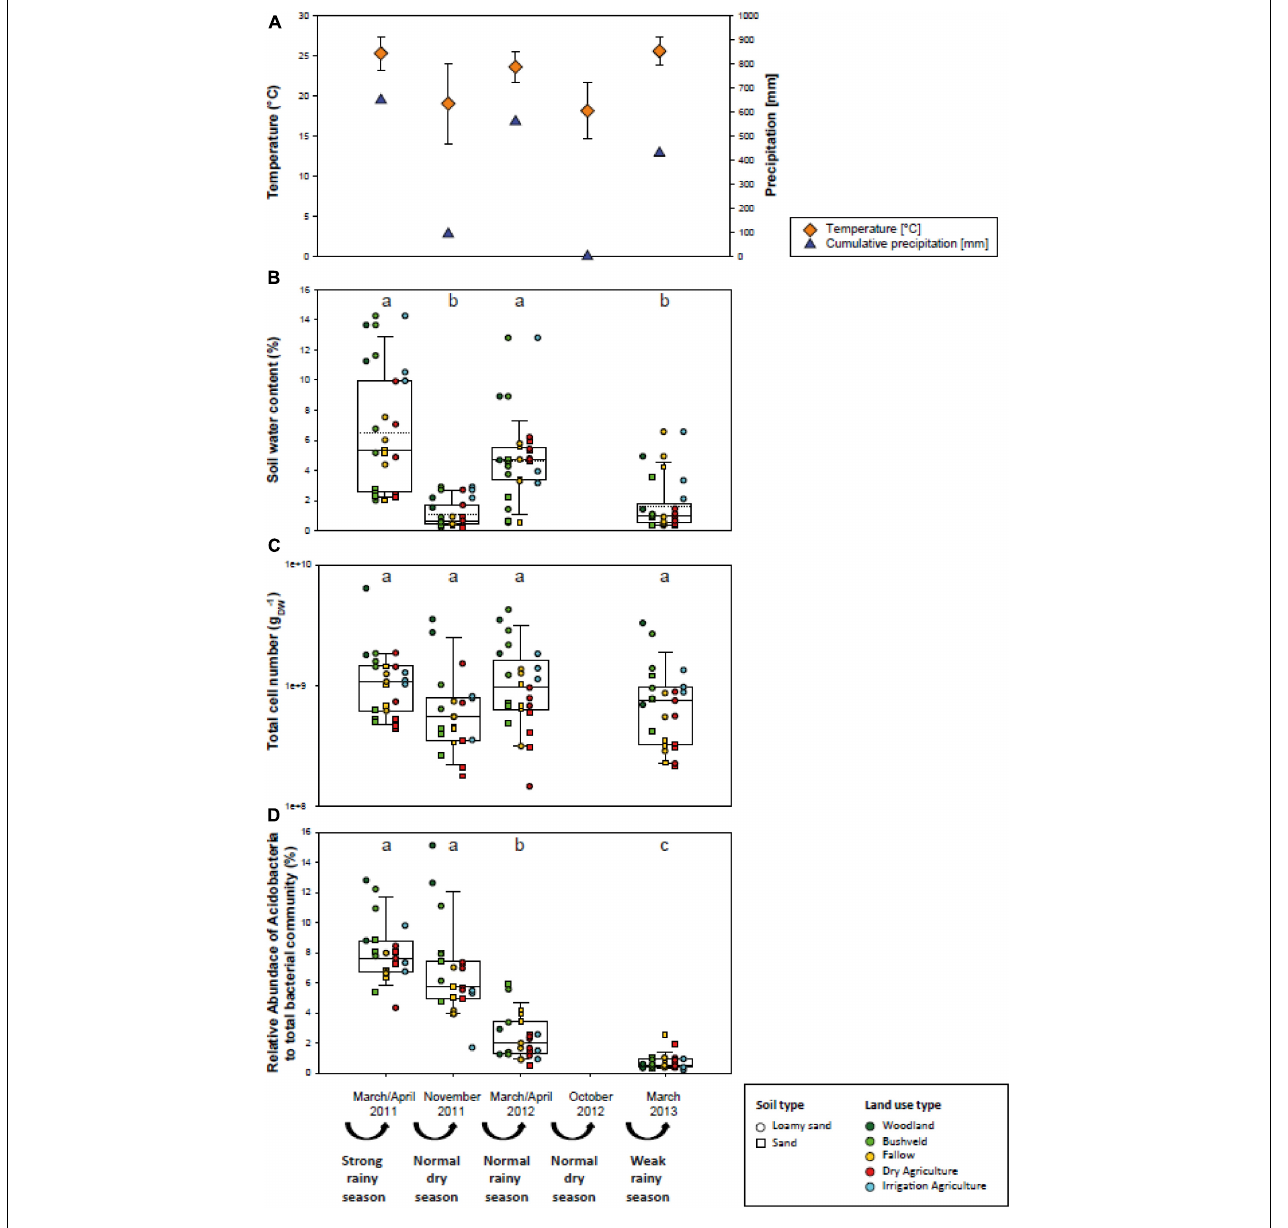
FIGURE 2 | Environmental parameters in different Mashare soils in March/April 2011 after a strong rainy season, in November 2011 after a dry season, in March/April 2012 after a normal rainy season, and in March 2012 after a weak rainy season. (A) Mean temperature values in ◦ C ( n = 30; orange diamonds; means and standard deviations are given) and cumulative precipitation values of the preceding season in mm (blue triangles). (B) Soil water content (%). (C) Total cell numbers (cells g DW - 1 ). (D) Relative abundance values of Acidobacteria among the total bacterial community determined in the Mashare soils collected at four time points (%). Values for individual sampling plots are given and denoted according to their soil and land use types (compare Figure 1 ). Lower and upper hinges of boxplots correspond to the first and third quartiles. Upper whisker extends from the hinge to the largest value no further than the 1.5 inter-quartile range and lower whisker from the hinge to the smallest value with at most 1.5 times the inter-quartile range. Different letters in lower case stand for statistically significant differences at p <